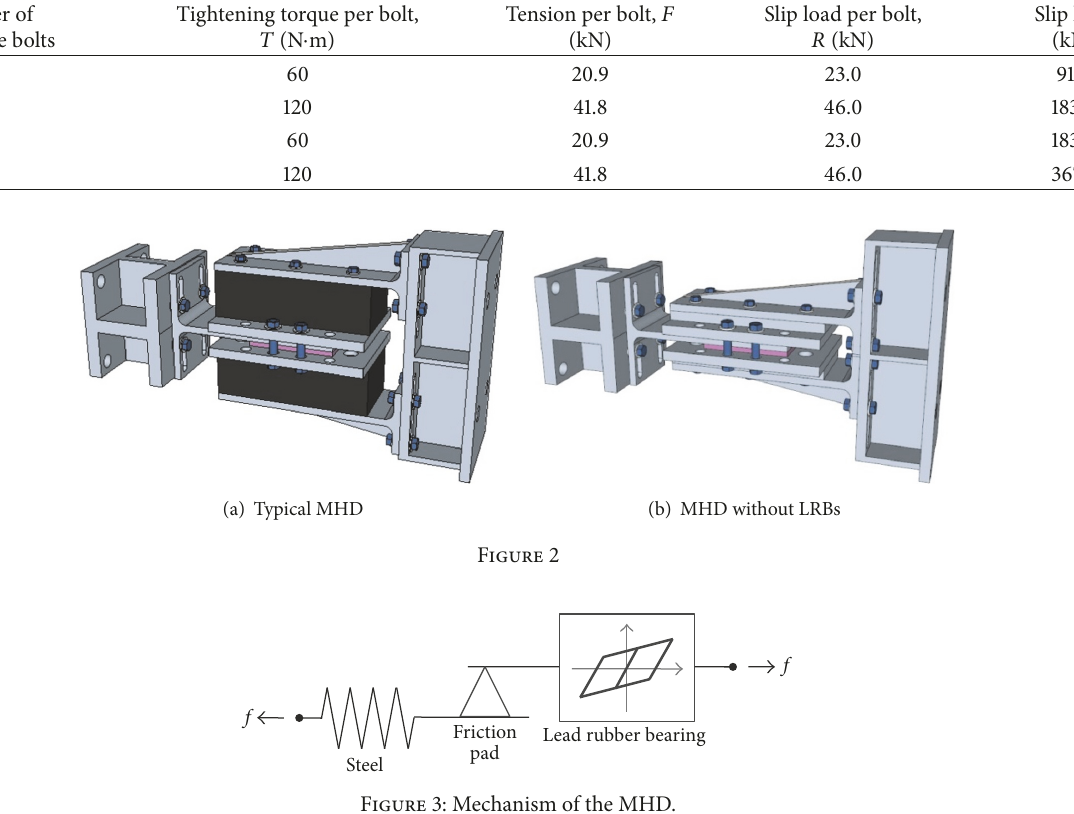
Figure 3: Mechanism of the